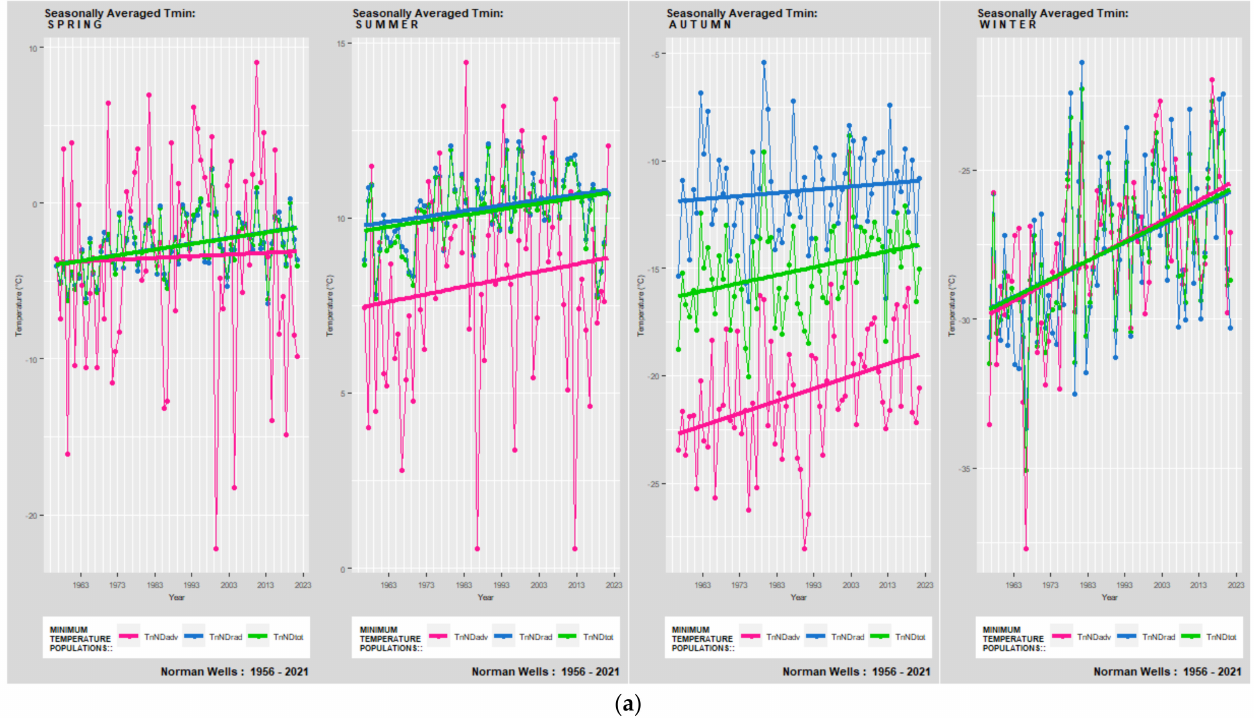
Figure 11. Pacific Coast (PAC); Port Hardy (BC). Seasonally averaged daily temperature minima ( a ) and maxima ( b ), listed in order of Spring, Summer, Autumn, and Winter. ( a )—Total Temperature Minimum ( TT n ) (green), Radiative Temperature Minimum ( RT n ) (blue), and Advective Temperature Minimum ( TT n ) (pink); ( b )—Total Temperature Maximum ( TT x ) (brown), Radiative Temperature Maximum ( RT x ) (orange), and Advective Temperature Maximum ( TT x ) (purple).